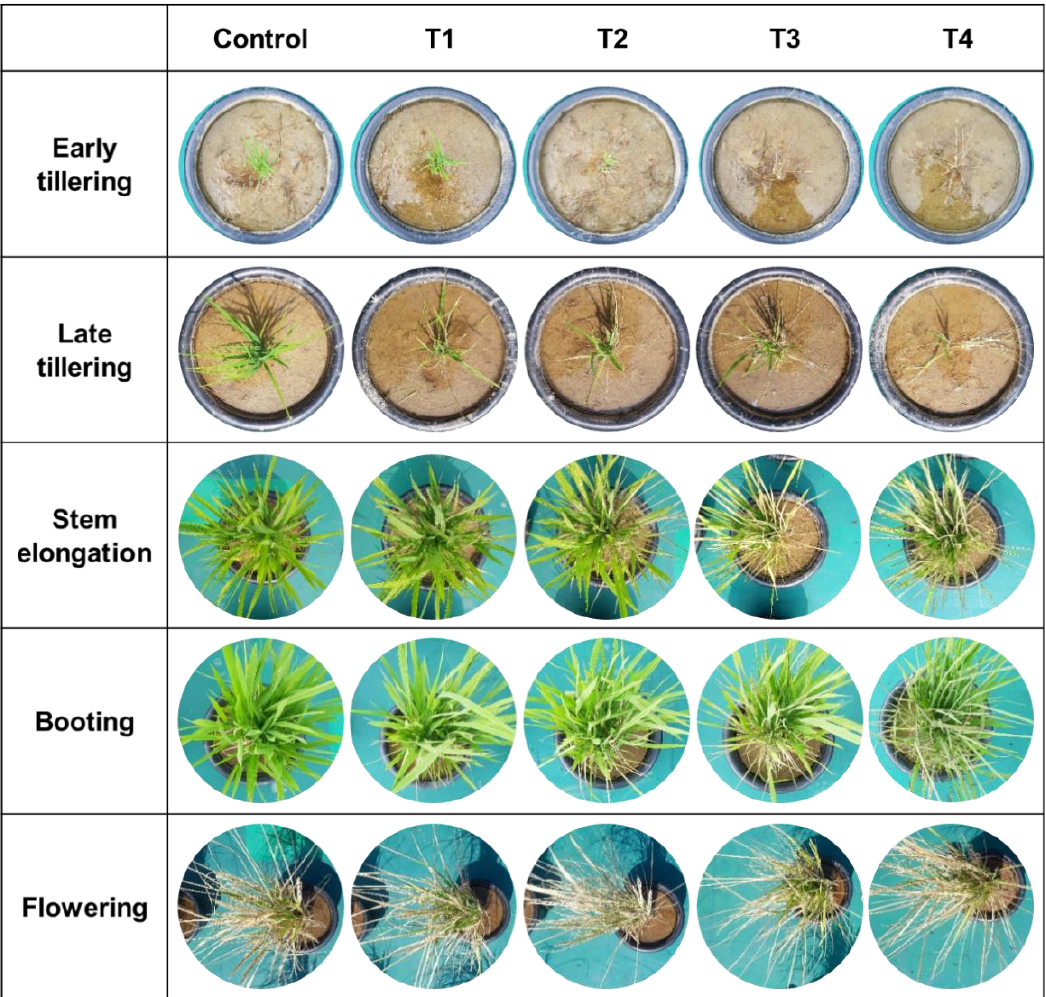
Figure 6. RGB image of the control group and toluene-exposed rice canopy. All images were captured five days after damage (DAD) at each growth stage.